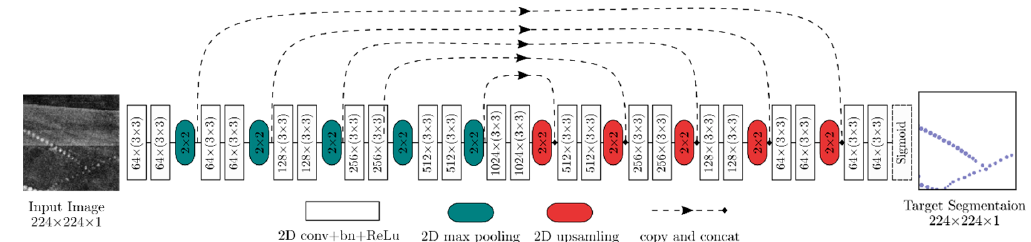
Figure 8. A schematic overview of the anisotropic 3D fully convolutional neural network for qanat feature segmentation on CORONA images.